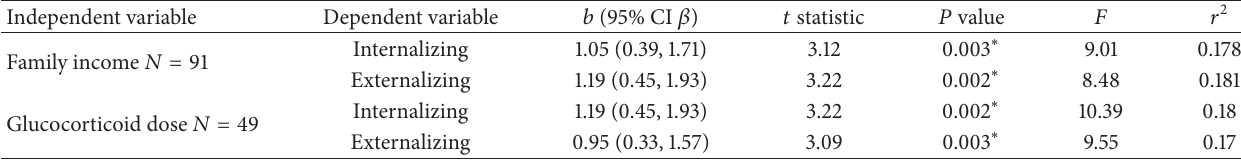
Table 10: Simple linear regression analysis on factors correlated with mean 𝑇 scores for summary